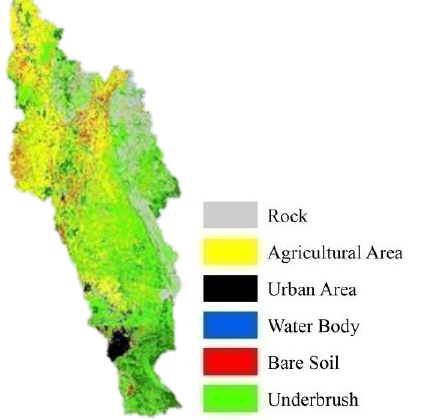
Figure 3. Current Scenario of Land Cover and Land Use